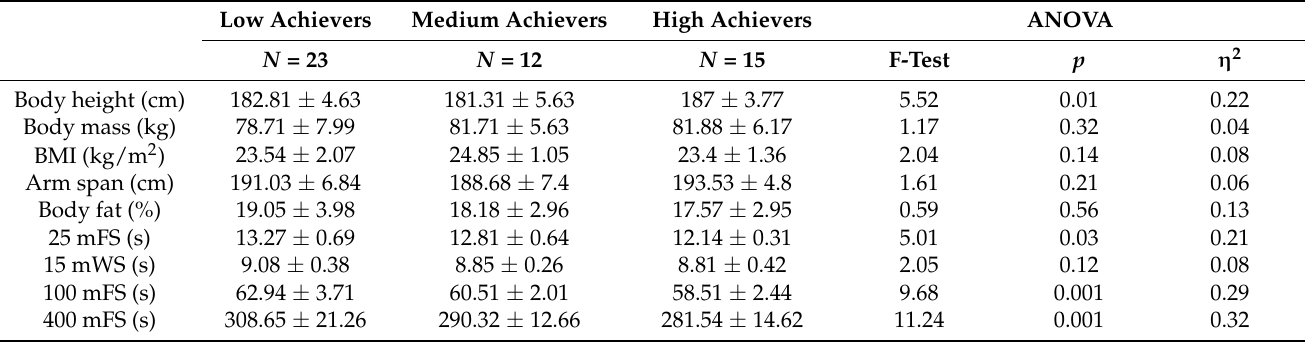
Table 3. Descriptive statistics and differences derived by analysis of variance (ANOVA) among qualitative groups for perimeter players (results are presented as means ± standard deviations).